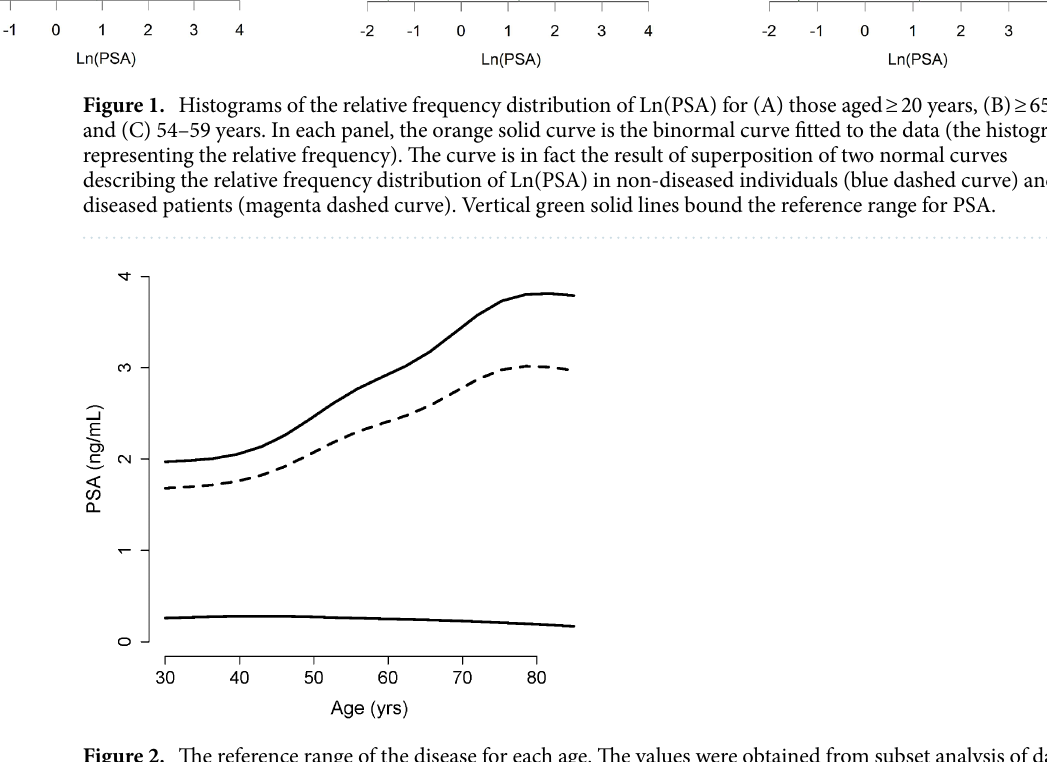
Figure 2. The reference range of the disease for each age. The values were obtained from subset analysis of data of men aged 20–39, 40–49, 50–59, 60–69, 70–79, and ≥ 80 years. The two solid lines represent the lower and upper limits of the reference range; dashed line, the 95th percentile of PSA. The values for each age group were calculated based on the mean and SD of the distribution of Ln(PSA) in non-diseased people in each subset 9